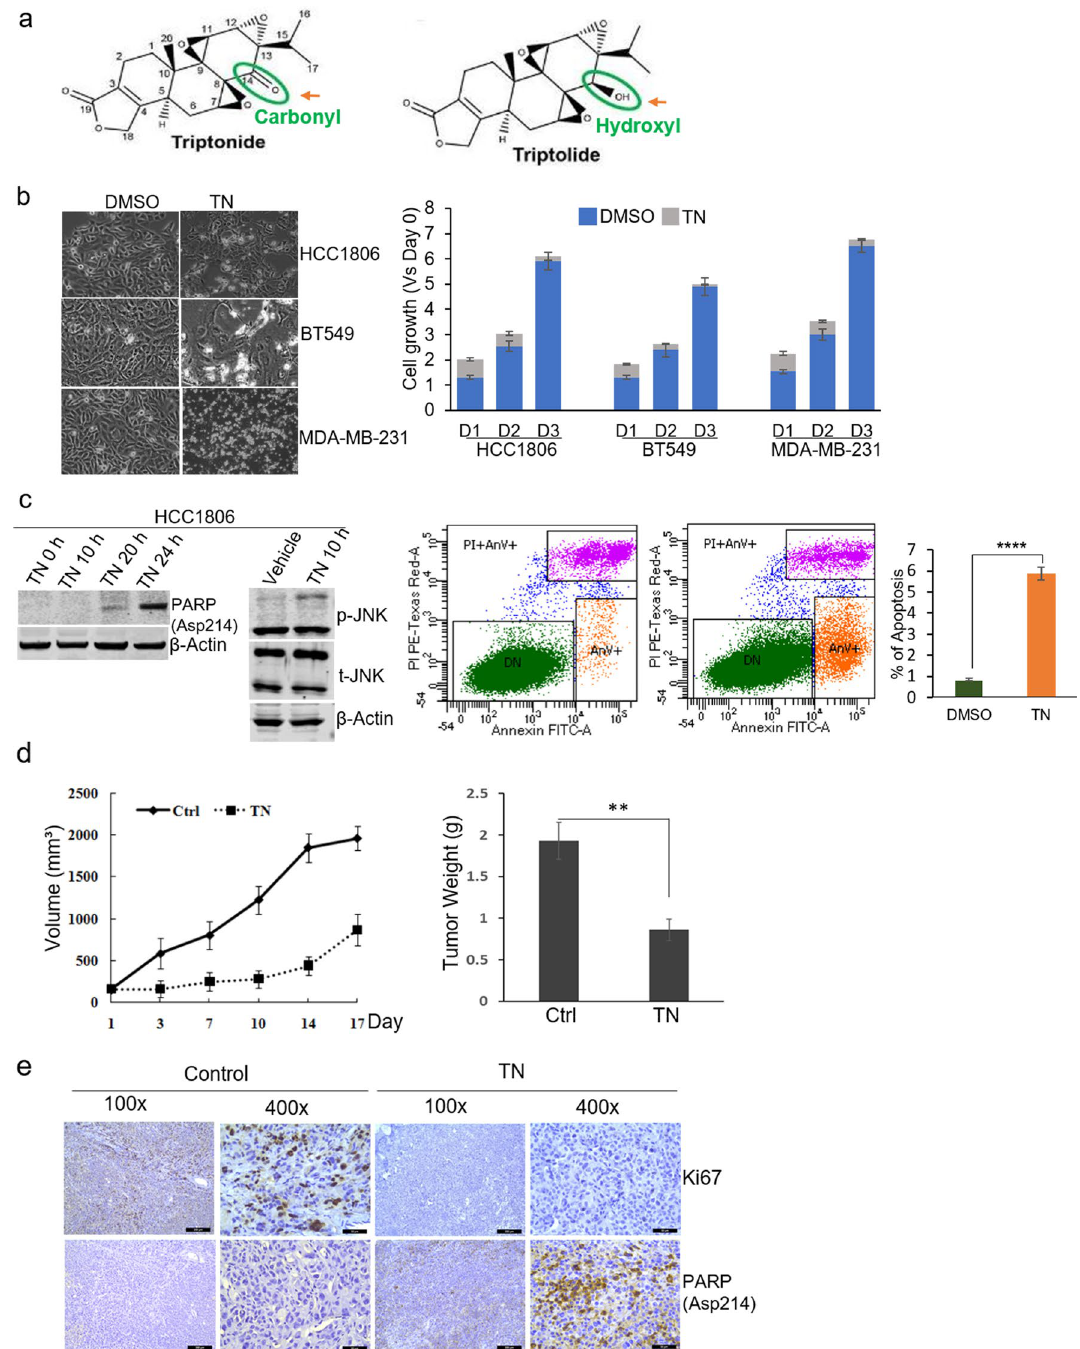
Figure 1. Triptonide inhibits TNBC cell growth in vitro and in vivo. ( a ) Chemical structures of triptonide and triptolide. ( b ) Left, representative images showing the effects of 0.2 µM triptonide treatment for 24-h in HCC1806, BT549, and MDA-MB-231 cells. Magnification, × 200. Right, quantified effects of 0.2 µM triptonide on cell growth measured by CellTiter-Glo assays. HCC1806, BT549, and MDA-MB-231 cells were treated for 24 h (D1), 48 h (D2) and 72 h (D3). Each bar is presented as mean ± SD (n = 3). ( c ) Left, immunoblotting of p-JNK, total (t)-JNK, cleaved PARP in HCC1806 cells treated with 0.2 µM triptonide. Right, apoptosis analysis of HCC1806 cells treated with 0.2 µM triptonide for 20 h by the FITC Annexin V/PI apoptosis assay. ( d ) Comparisons of MDA-MB-231 xenograft mammary tumors in mice treated with vehicle or triptonide. Graphs show tumor volume changes with time and tumor weight at harvest. Each bar is presented as mean ± SD (n = 4). **, p < 0.01. ( e ) Expression of Ki67 and cleaved PARP in MDA-MB-231 xenograft tumor tissues examined by immunohistochemistry assays. Magnification, ×